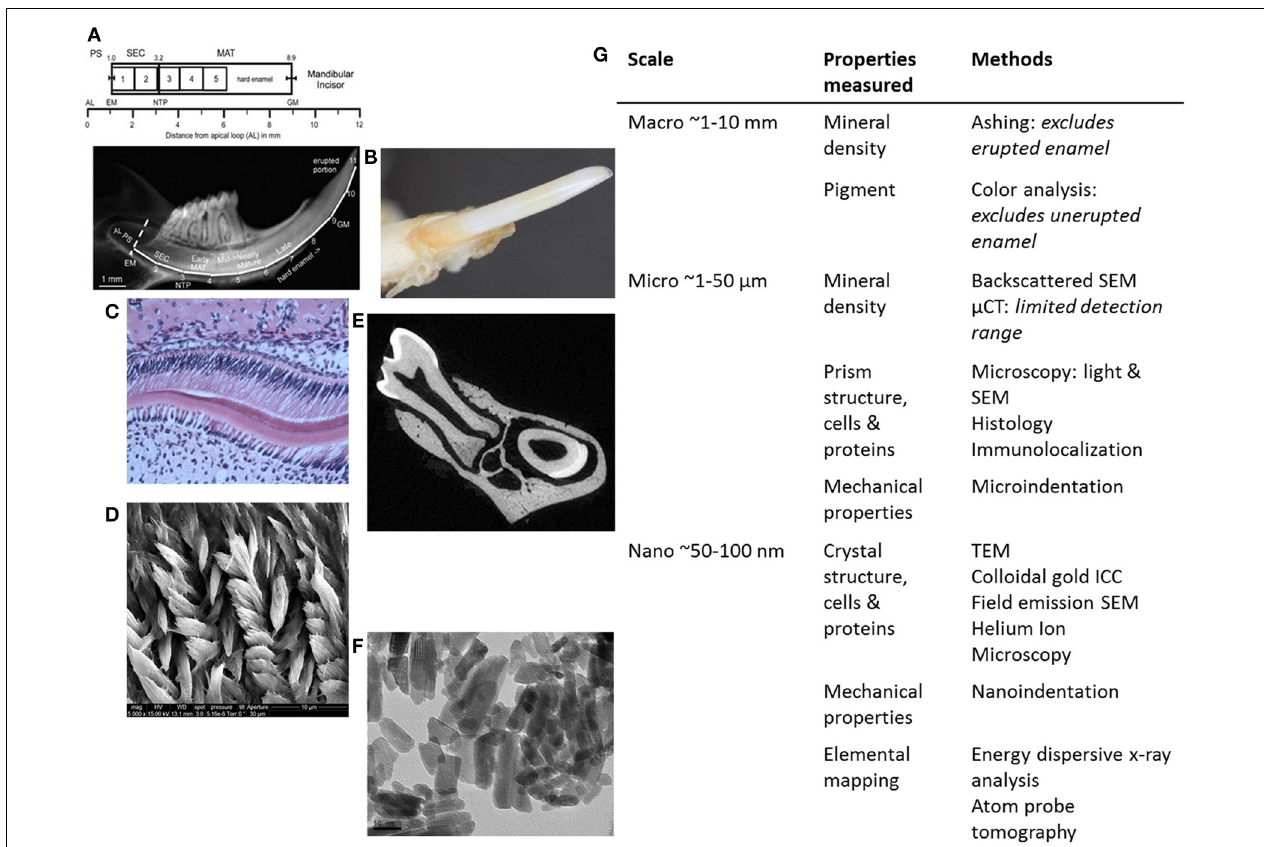
FIGURE 2 | Summary of methods for analyzing genetically modified rodent enamel. (A–F) Representative images of WT mouse enamel analyzed by different methods are shown, with the corresponding table (G) in which methods are separated according to scale (mm, μ m, and nm) and enamel properties of interest to analyze and compare mutant enamel with WT: mineral density, pigment, structure of prisms and crystals, cells, proteins, mechanical properties and elemental mapping. Within the macro scale ( ∼ 1–10mm) of enamel analysis (A) mineral density can be determined